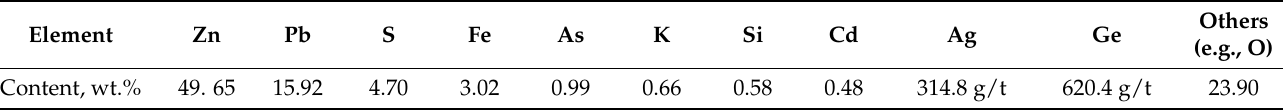
Table 1. XRF results of the GCR.